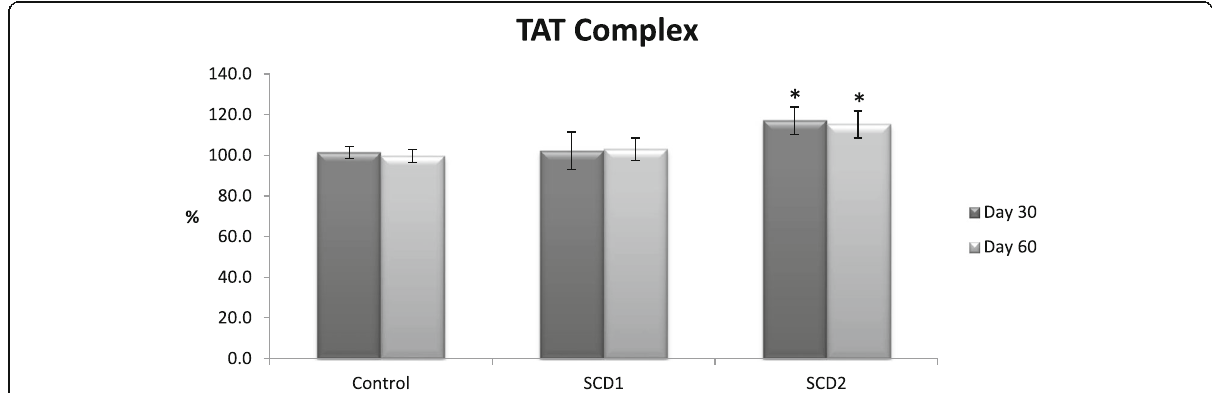
Fig. 2 In vivo effects of Syzygium cumini and control on TAT complex in rabbits. Data is represented as average values ± SEM, where n = 10; Two different doses of S. cumini were used as follows: SCD1:150mg/kg; SCD2: 500 mg/kg, * p ≤ 0.05 significant as compared to